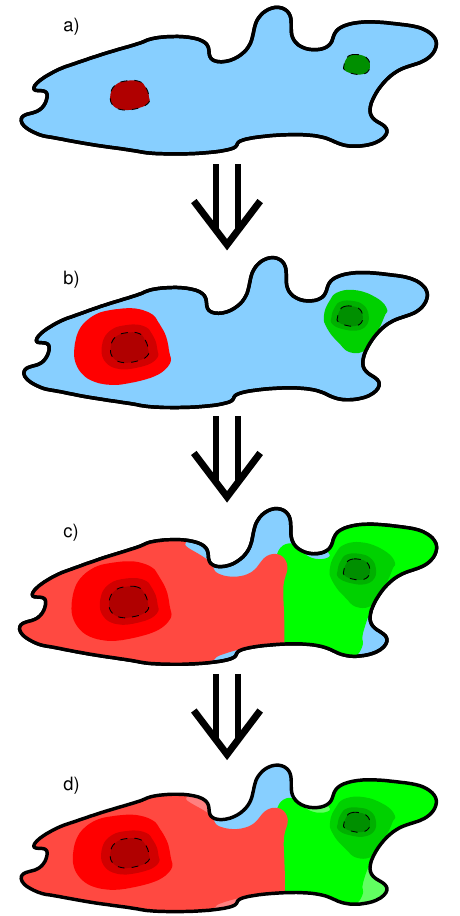
Fig. 2. Schematic representation of cloud splitting. A cloud ( a ; the blue area, solid line) with multiple distinct cores (the red and green areas in a , dashed lines) is divided between the two cores by use of the region growing process, the lighter red and green regions in (b) and (c) . Sudden increases in local cloud base are avoided. The remaining cloud, the blue parts in (c) , are assigned to their respec- tive cores if no other core connects to these areas, or are treated as separate remnants if multiple cores are connected to them, the blue area in (d) . Actual splitting occurs in three dimensions ( x , y , and t ) instead the two depicted. The figure displays the cloud splitting in two dimensions out of x , y , and t ; the algorithm works similarly in the third dimension. For further details, see the